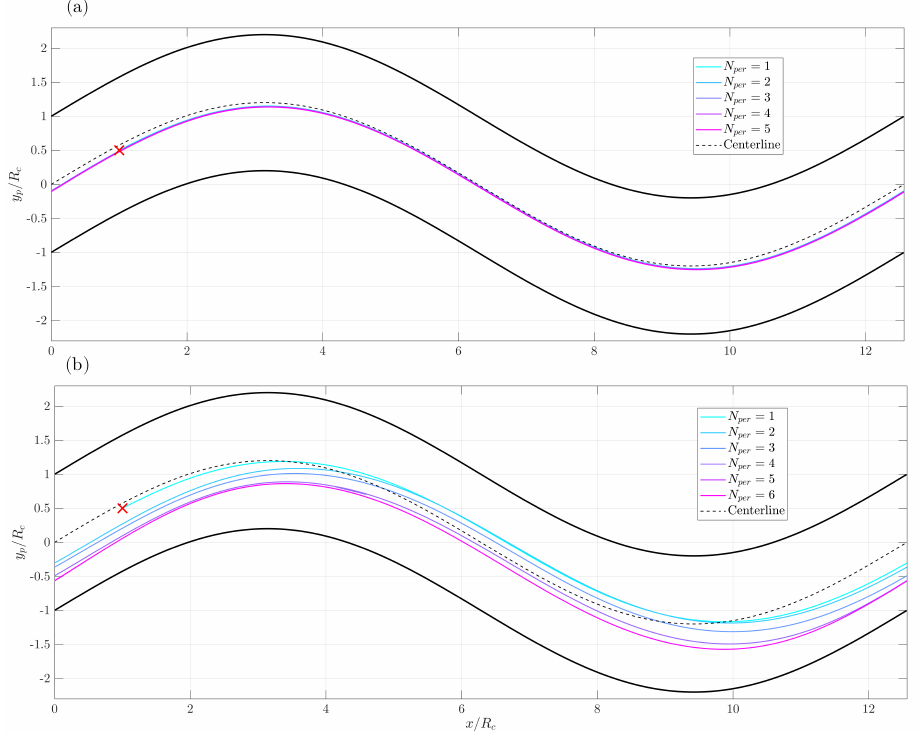
Figure 25. Trajectory of the particle in the xy plane, sequenced as periods (colored lines). ( a ) Re = 12, ( b ) Re = 115. The red cross indicates the initial particle position, the bold black lines correspond to the pipe interface, and the dashed black line correspond to the centerline of the